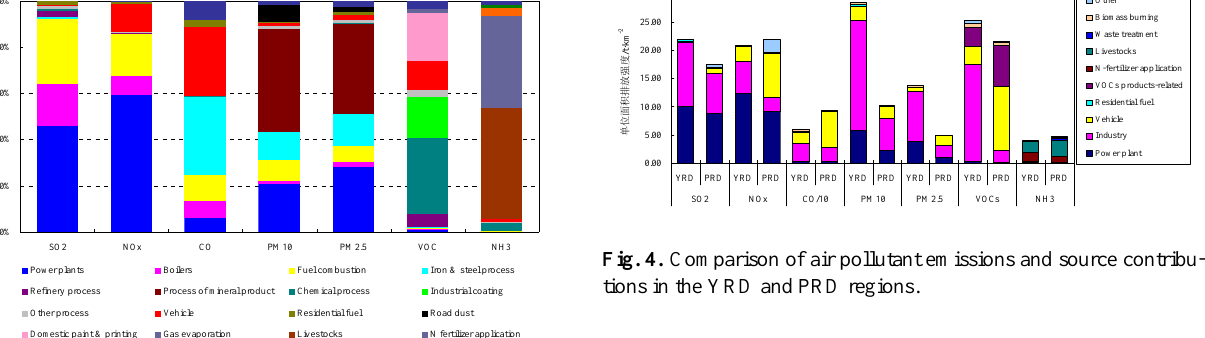
Fig. 3. Emission contribution of source categories in the YRD region in 2007.